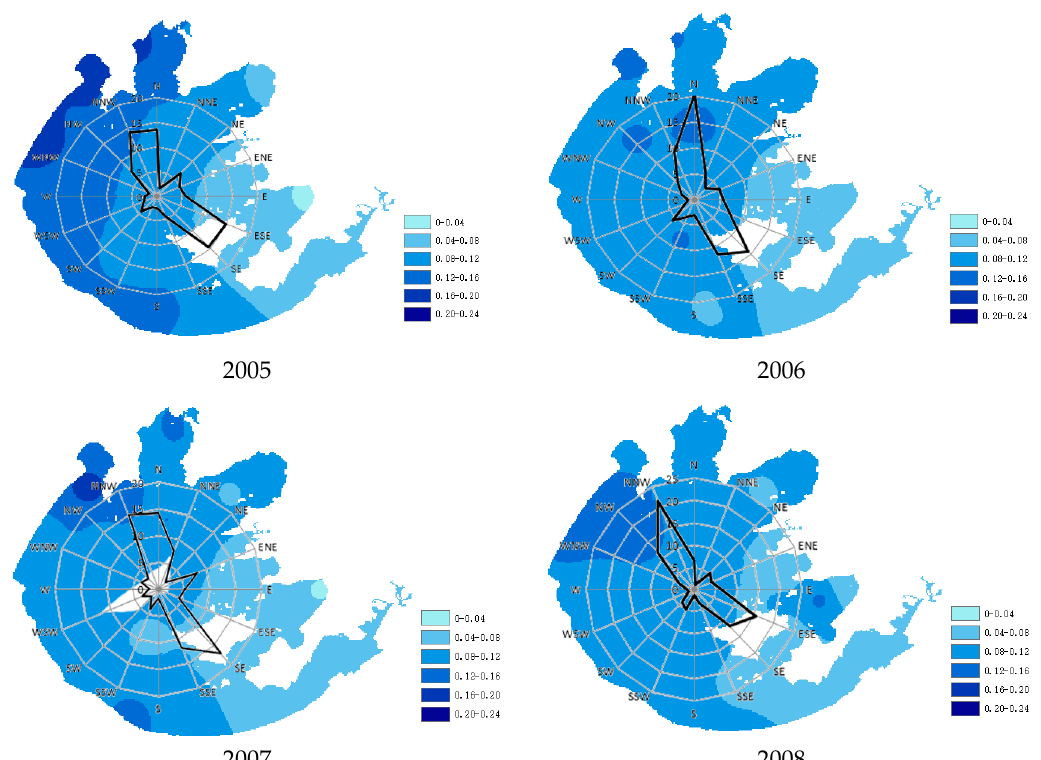
Figure 4. Map showing the spatial distribution of mean annual total nitrogen (TN) concentration (mg·L − 1 ), superimposed by the plot (signified by black line) of wind direction occurrence.